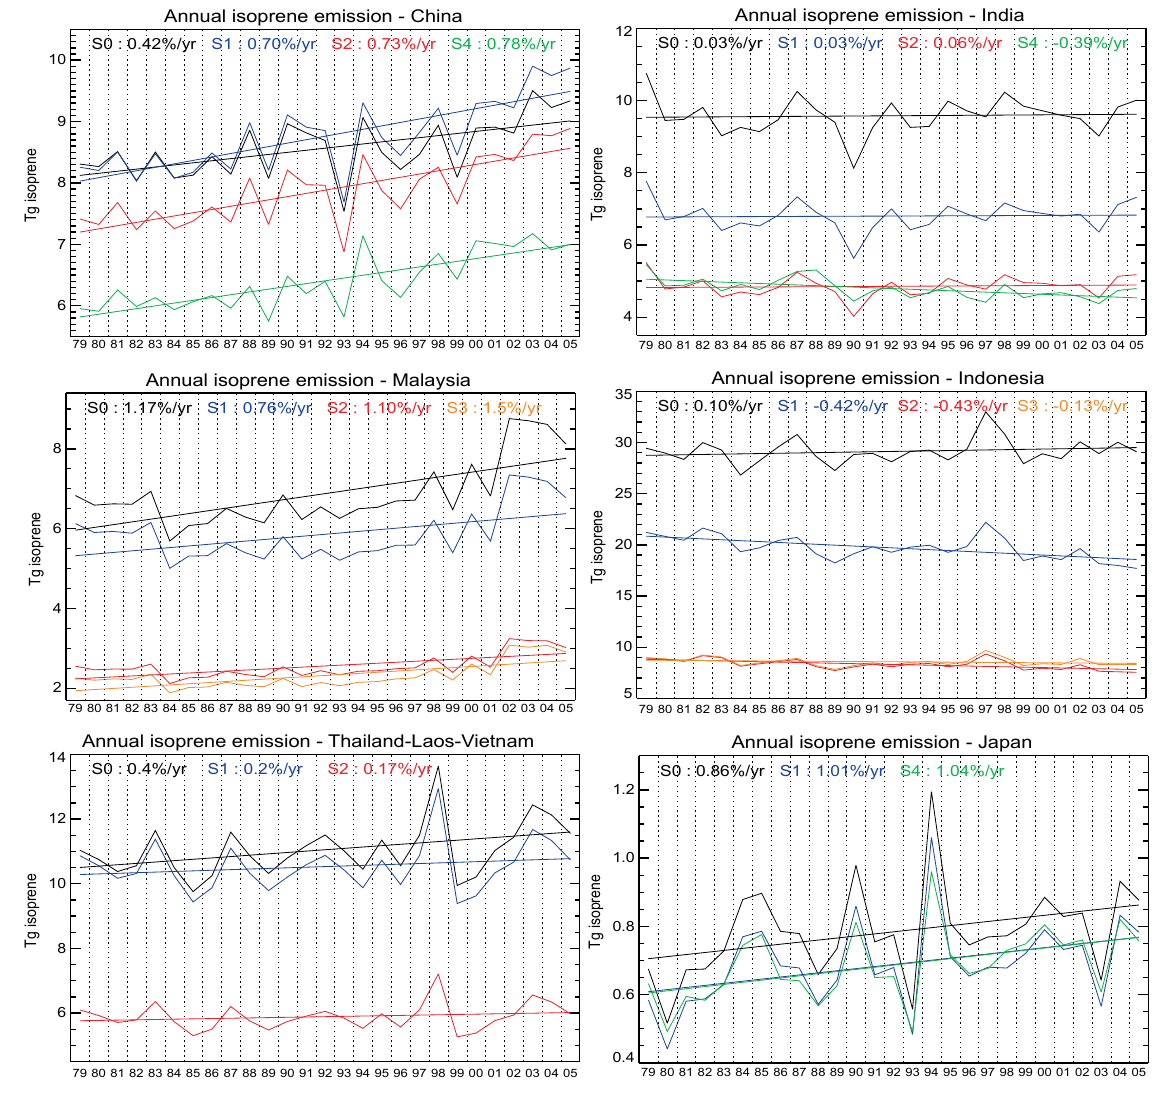
Fig. 10. Annual isoprene emission per country between 1979 and 2005. The colors denote the different simulations: S0 in black, S1 in blue, S2 in red, S3 in orange, and S4 in green (Table 1). Relative trends obtained by linear regression are given inset following the same color code. Scenarios yielding identical results are not shown, e.g., S2 and S3 over